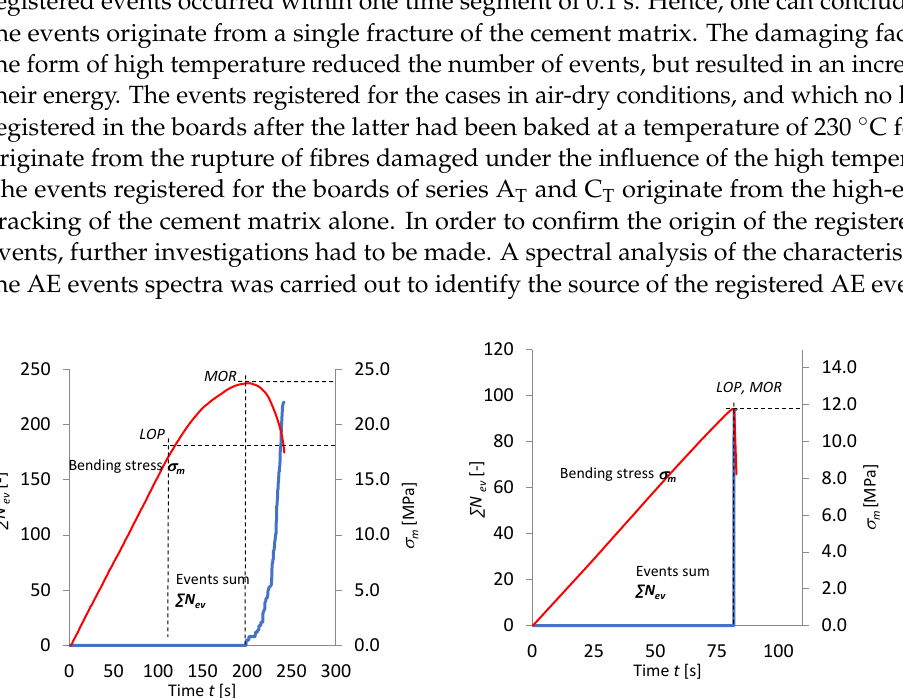
Table 3. Summary of representative values of events sum ∑ N ev , events maximum energy E ev and events average energy E ev,avg for boards of series A R and C R in dry-air condition and series A T and C T exposed to temperature of 230 °C for 3 h.